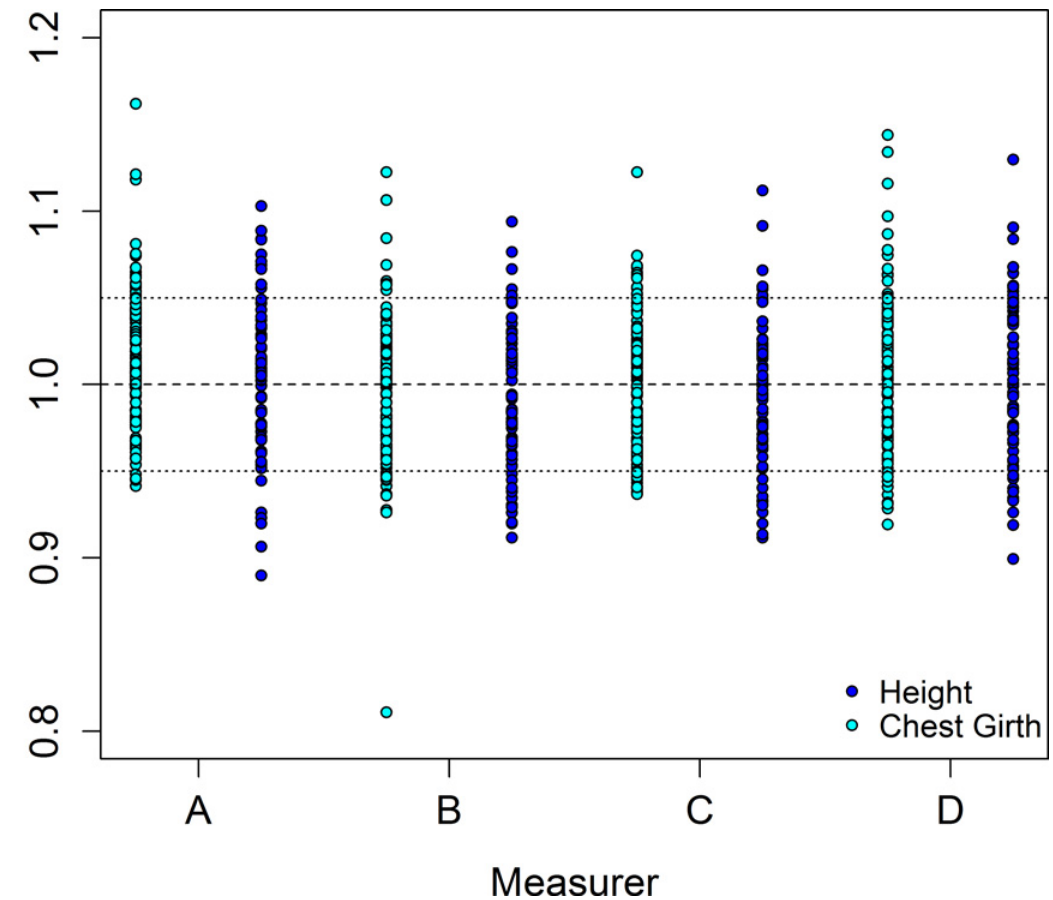
Fig 7. Adjusted photographic measurements relative to actual measurements of elephants, separated by measurer. Photographic heights (blue points) were adjusted by the equation 10.8 + 0.99 x Photo Height ; photographic chest girths (cyan points) were adjusted by the equation 25.2 + 2.5 x Photo Girth . The long-dashed line represents actual heights. Short-dashed lines represent 5% above and below actual heights.